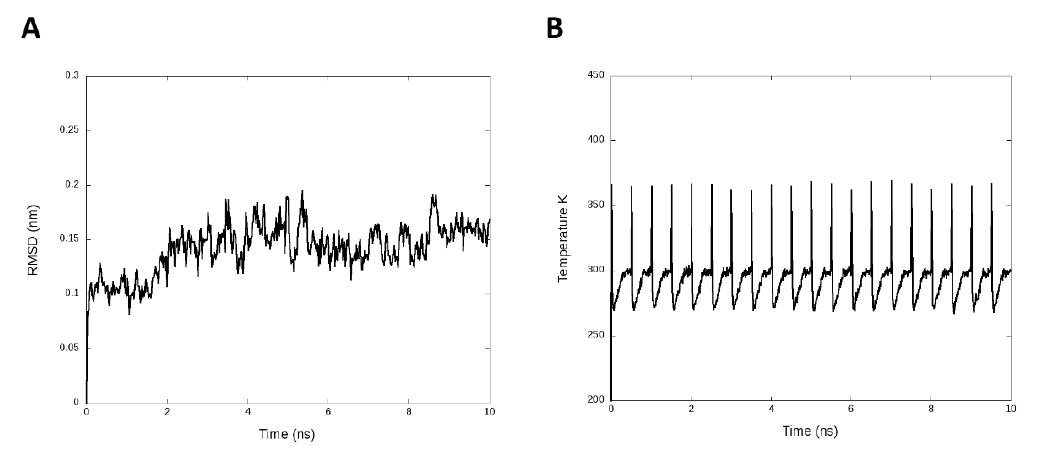
Figure 2. Simulated annealing analysis. ( A ) Root-mean-square deviation (RMSD) by 10 ns of the annealing simulation. ( B ) Temperature plot with the cycles generates along the MD annealing